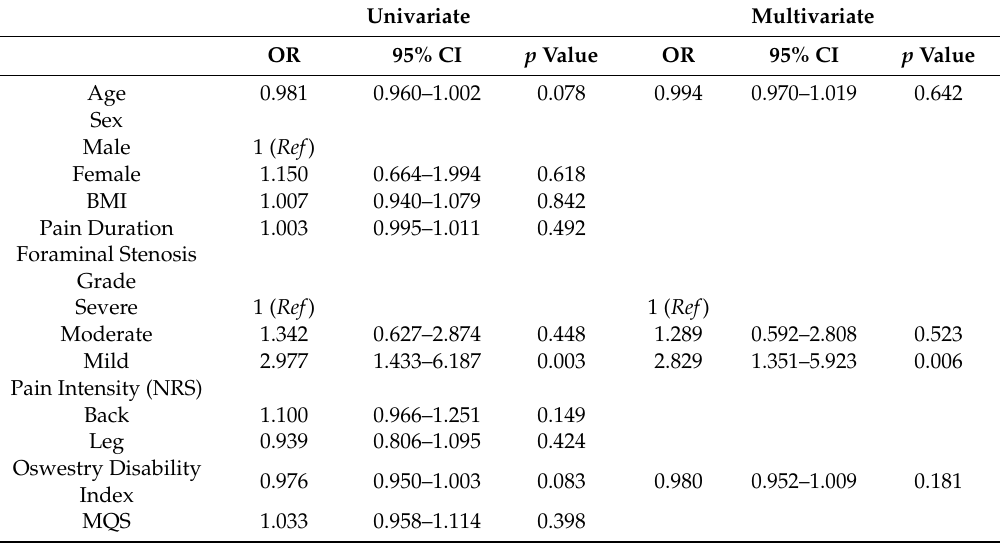
Table 2. Logistics regression analysis of factors associated with successful response at 6 months after decompressive adhesiolysis neuroplasty using an inflatable balloon catheter.